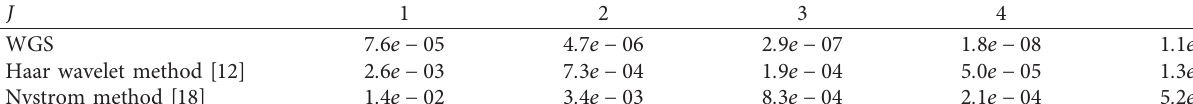
Table 8: Comparison of maximum absolute value errors with others for Example 4.